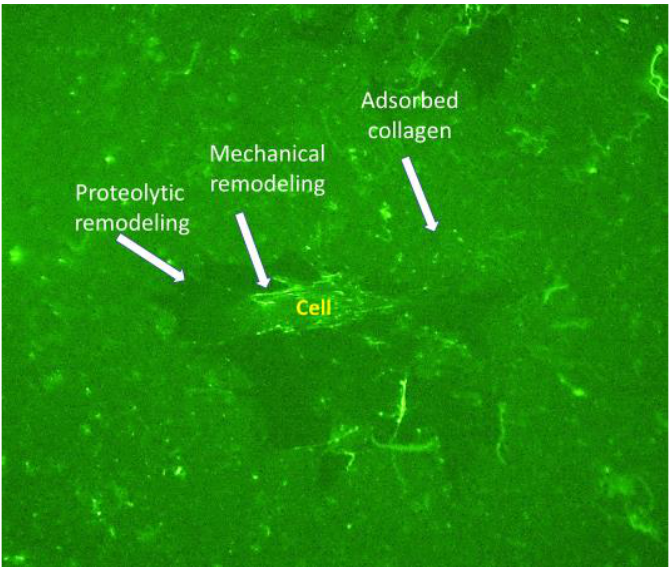
Figure 2. FITC labelled collagen remodeling by stem cells. ADSCS were cultured for 24 h on the fluorescent FITC-MTC substratum (green). The white arrows point to the places of adsorbed collagen with fibril-like reorganization and places of collagen removal caused by cellular proteolytic ac-